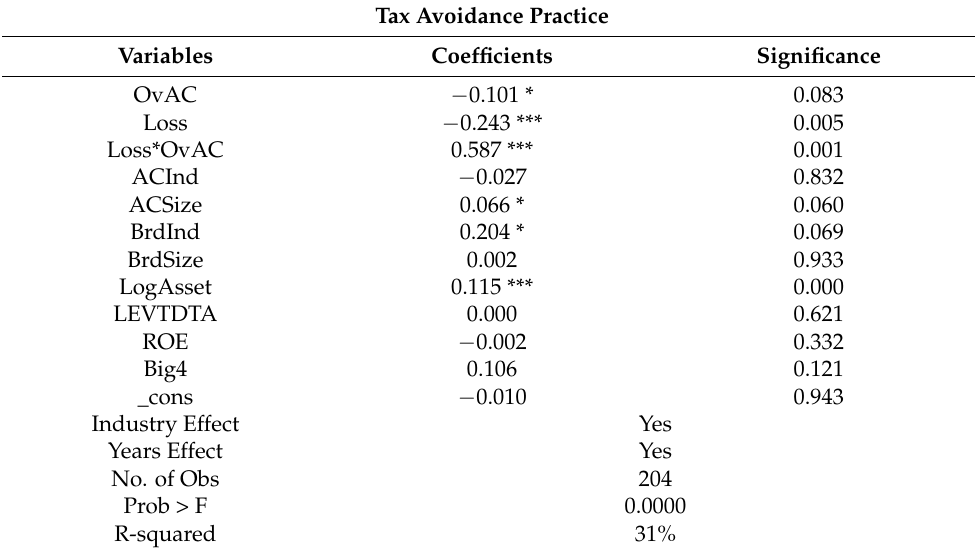
Table 6. Additional